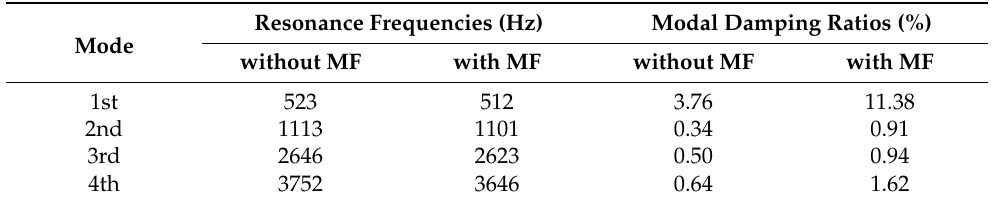
Table 4. Identified resonance frequencies and modal damping ratios of armature assembly with and without MF.